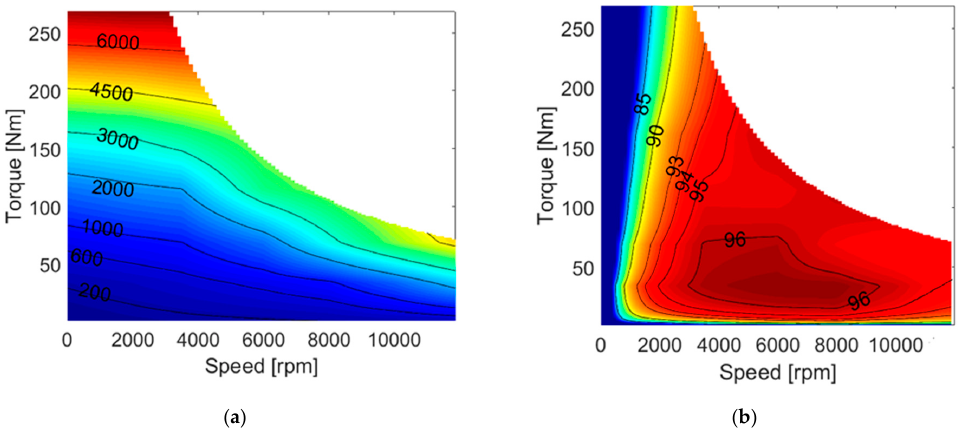
Figure 5. ( a ) Interior-permanent-magnet motor losses [W] and ( b ) efficiency [%].